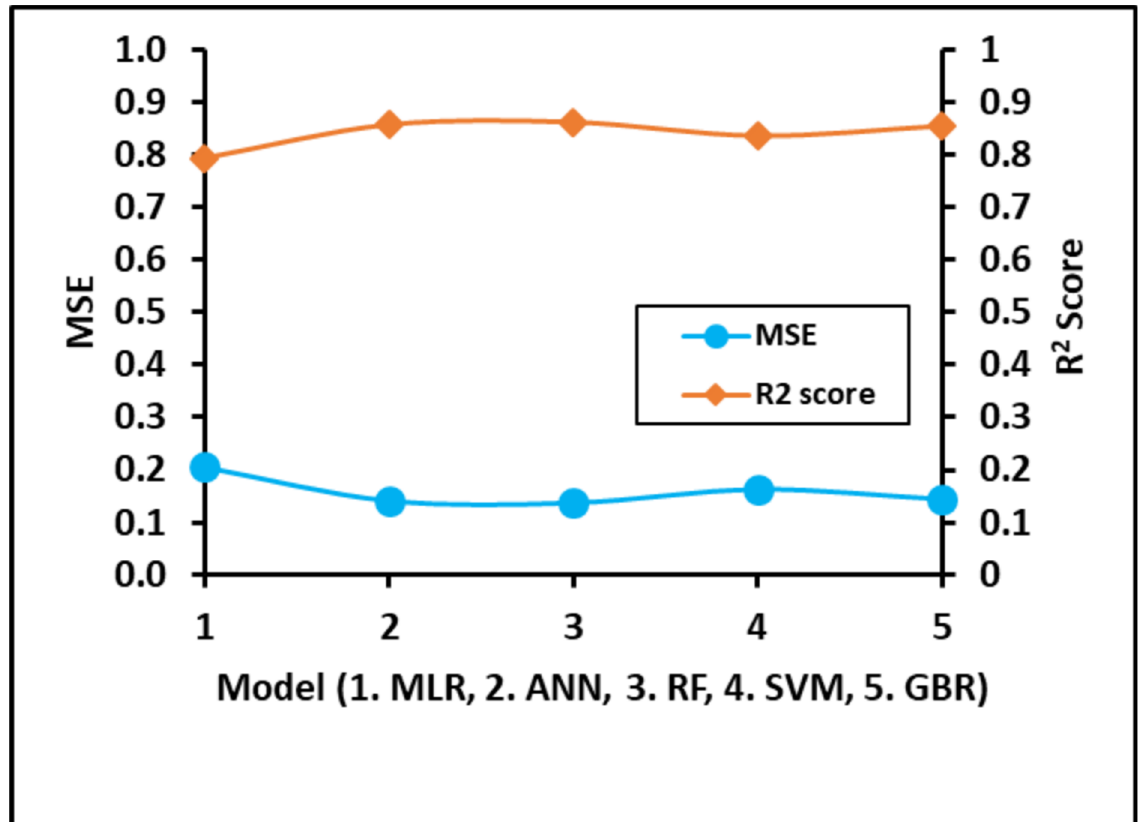
Figure 14. MSE and R 2 plot of one linear and four ensemble learning model for predictive TOC modelling. Four ensemble learning models have equally performed prediction outputs. The left y ‐ axis scale presents MSE value whereas the right y ‐ axis displays R 2 score.